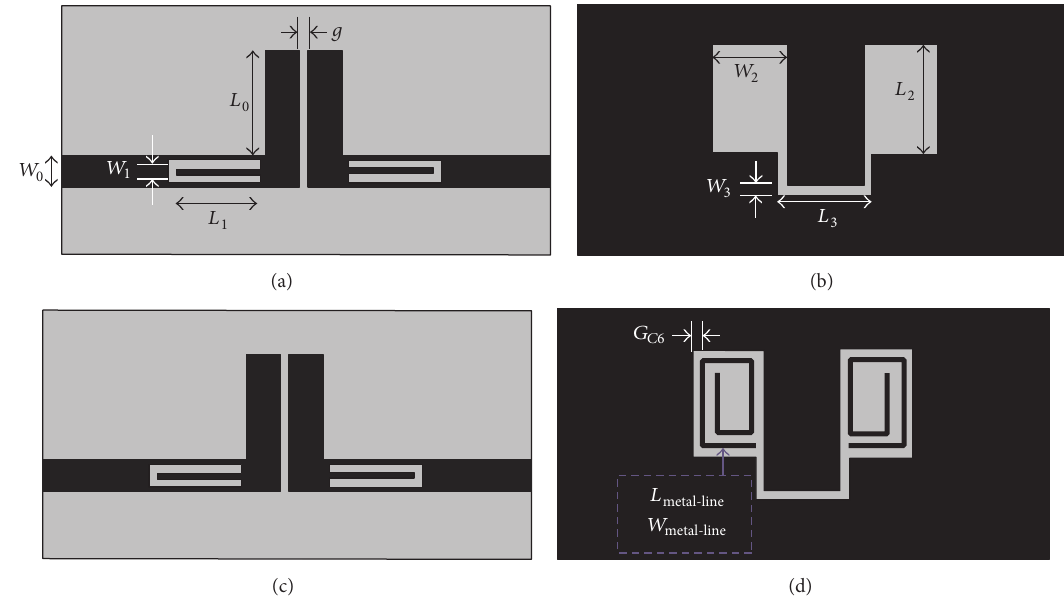
Figure 18: Schematic diagrams of UWB BPF [58]: (a) top view, (b) bottom view, (c) top view with notch band implementation, and (d) bottom view with notch band